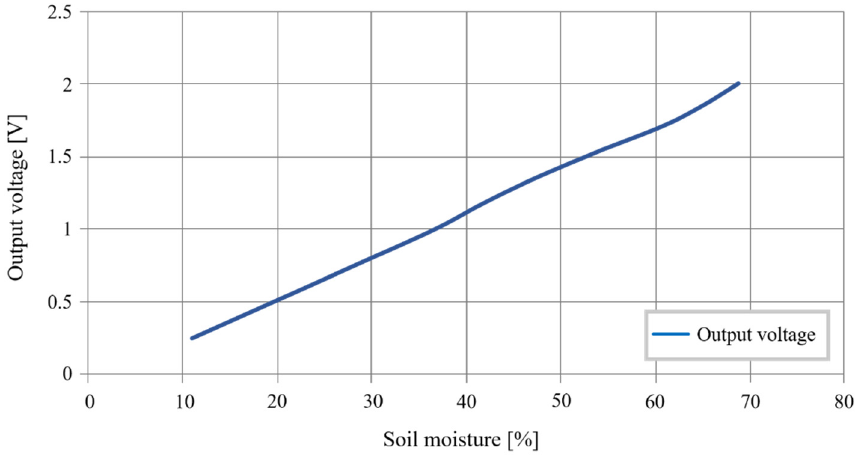
Figure 31. Sensor’s output voltage as a function of the soil moisture.